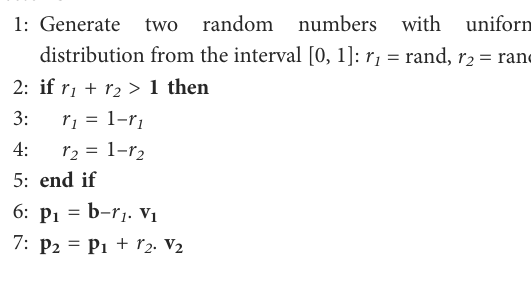
FIGURE 6 Generating a point at random location inside a triangle in 3D